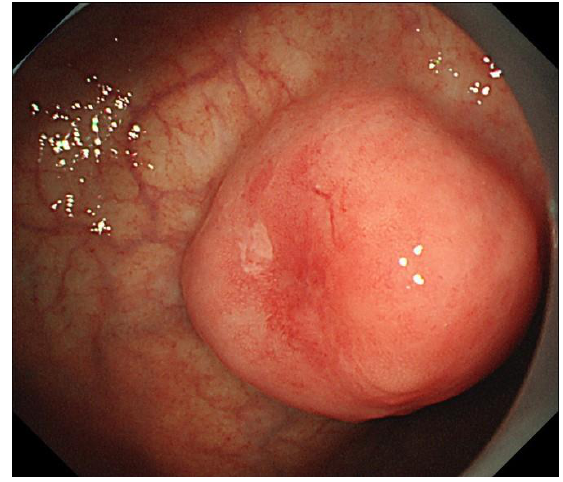
Figure 2. Endoscopic images of an EBV-associated gastric carcinoma. Submucosal tumor-like morphology is one of the features of EBVaGC.